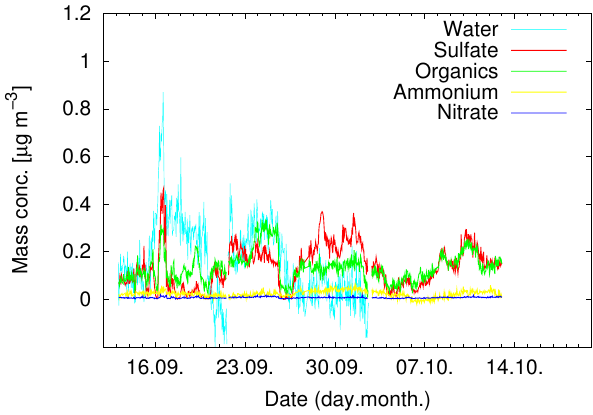
Fig. 2. Time series of AMS mass concentrations of sulfate, total organics, ammonium and nitrate for the aerosol sampled between 5 August 2006 and 11 September 2006. Four periods were selected for subsequent analysis. These are labelled “Clean” (indicating low levels of all detected species) and 1, 2a and 2b, during which high sulfate levels were detected. See Figs. 9–12 for Lagrangian mod- elling of these periods.